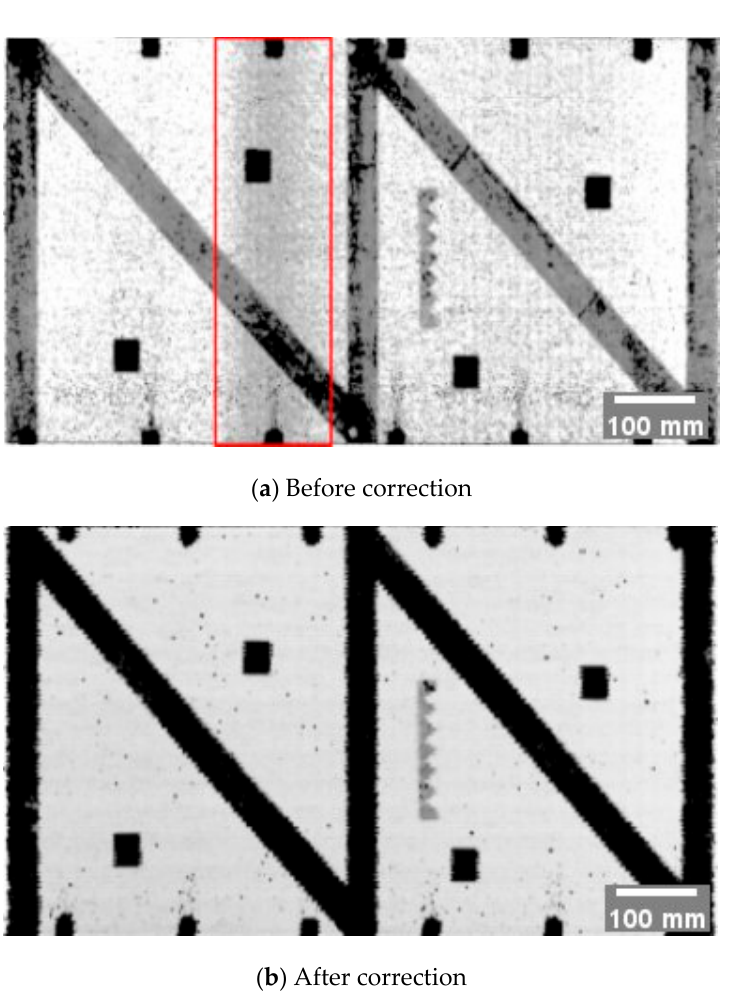
Figure 12. C-scan images of the specimen with simulated defects.